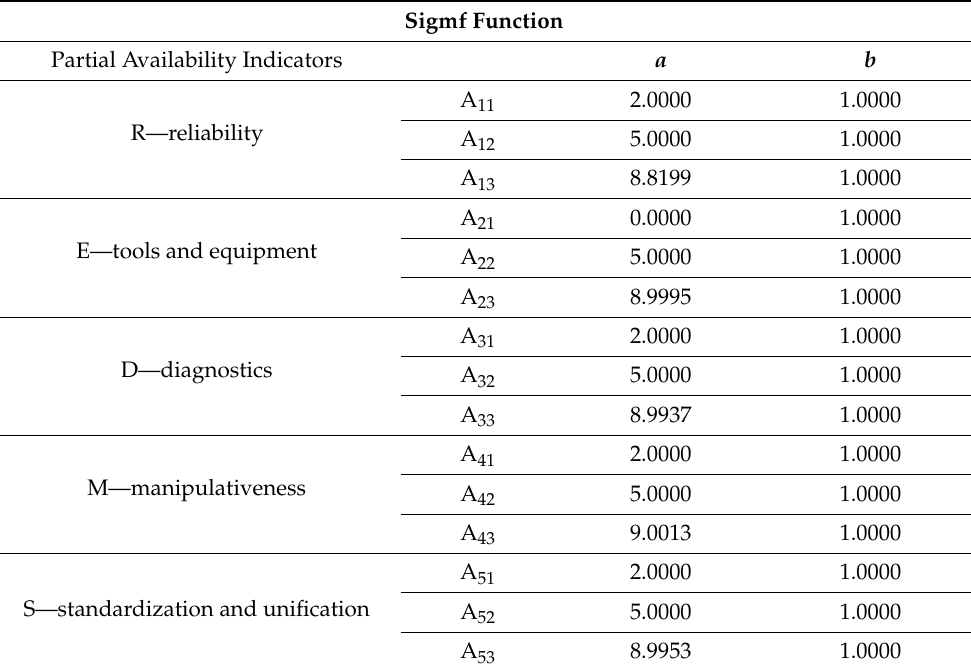
Table 6. Evaluation parameters of partial indicators for the Sigmf function.